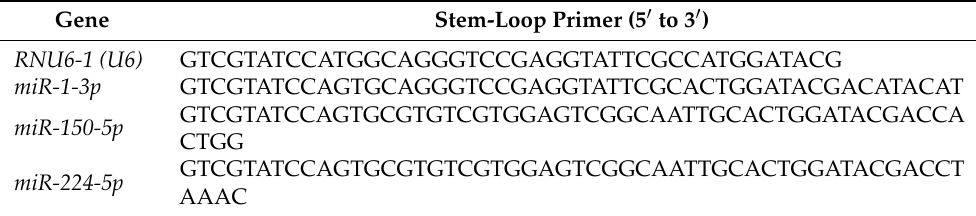
Table 1. Stem-loop primers of miRNAs.